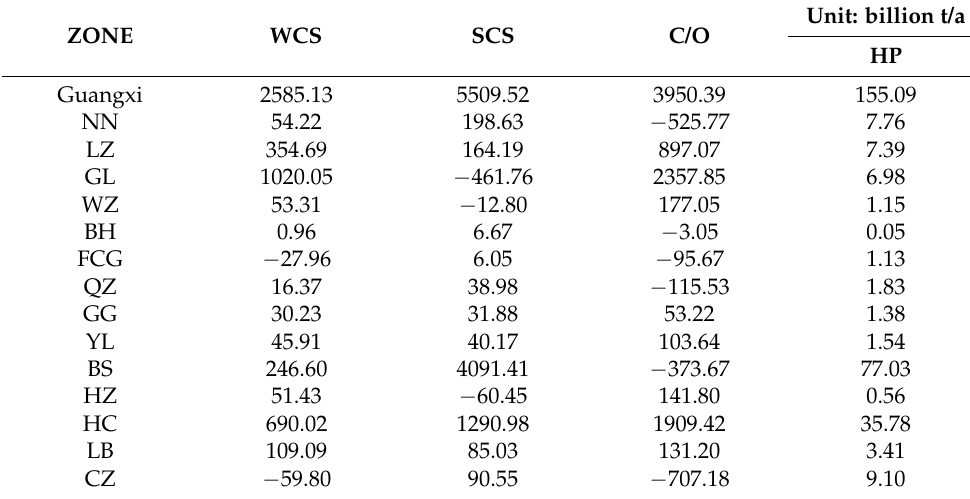
Table 2. Changes in regulation services from 2005 to 2020.